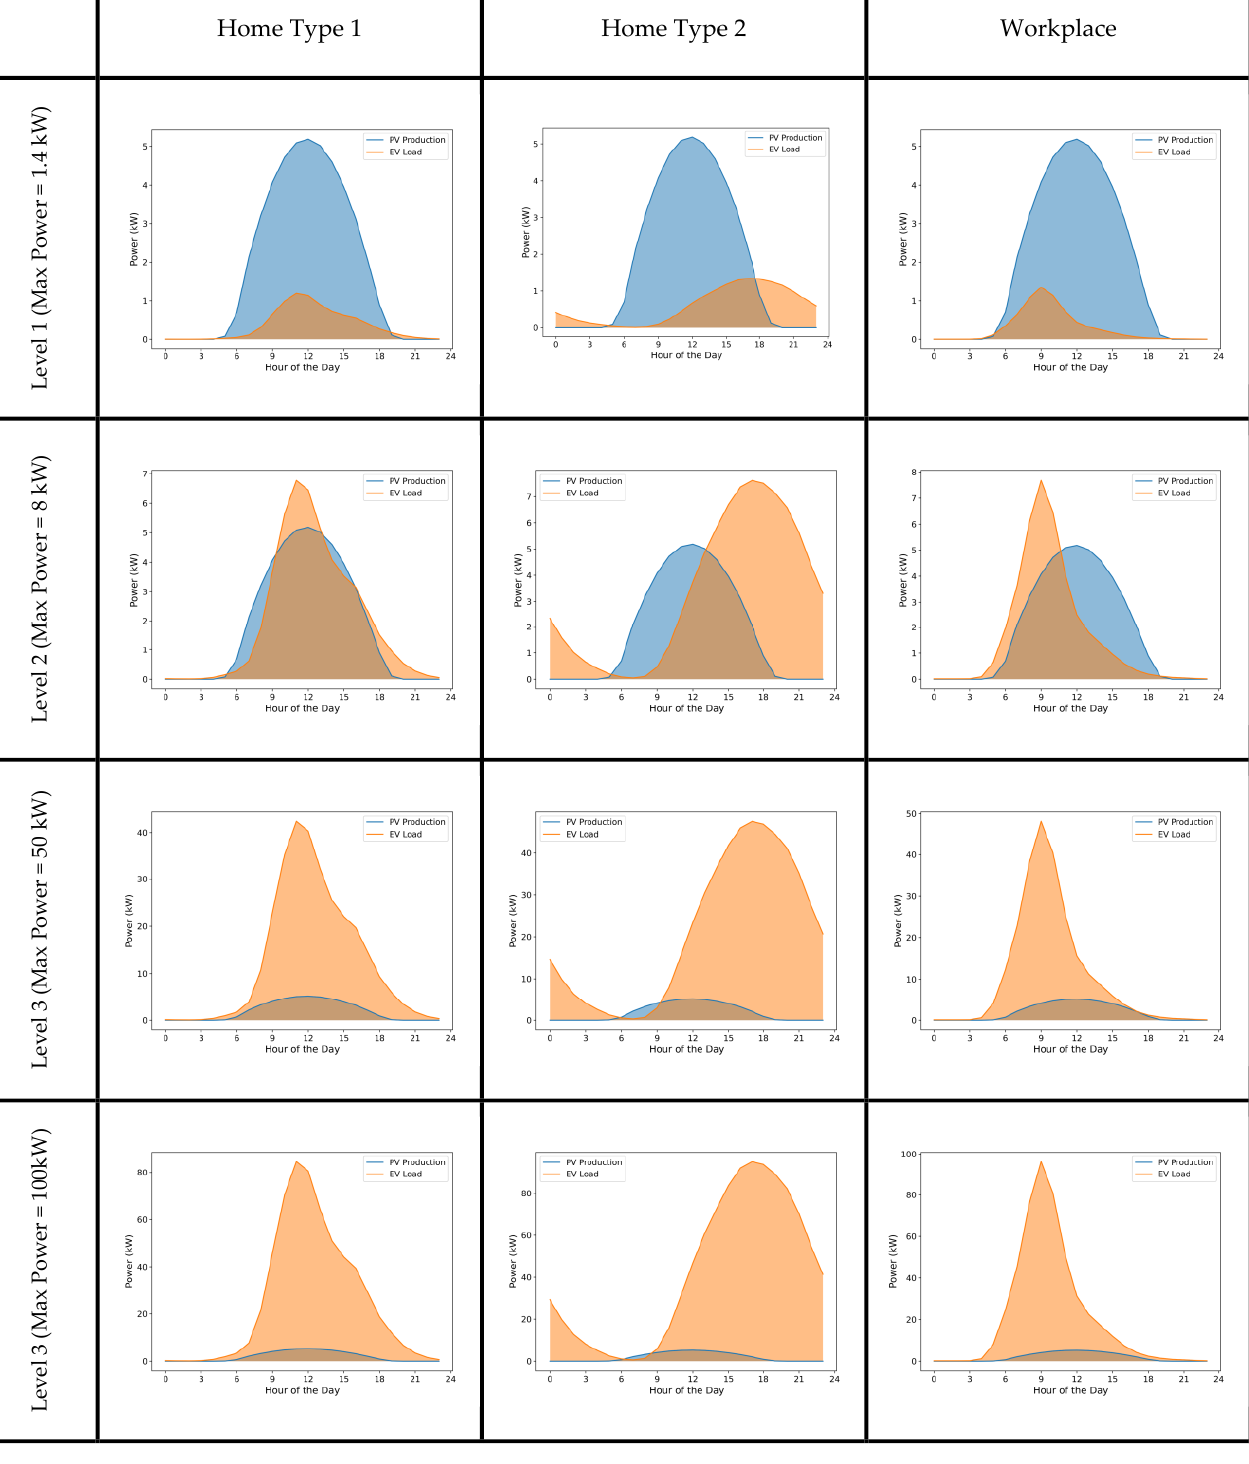
Figure 13. Load-matching results (kW) between the PV system and EV charging stations supplying multiple EVs, using the load profiles proposed by Zhang et al. [66] for a day with maximum energy production (June 26) in London, Ontario. The three levels of EV charging stations in the North American EV standards are used. Load matching is plotted in different charging locations. In Home Type 1, the EV users return home at noon.